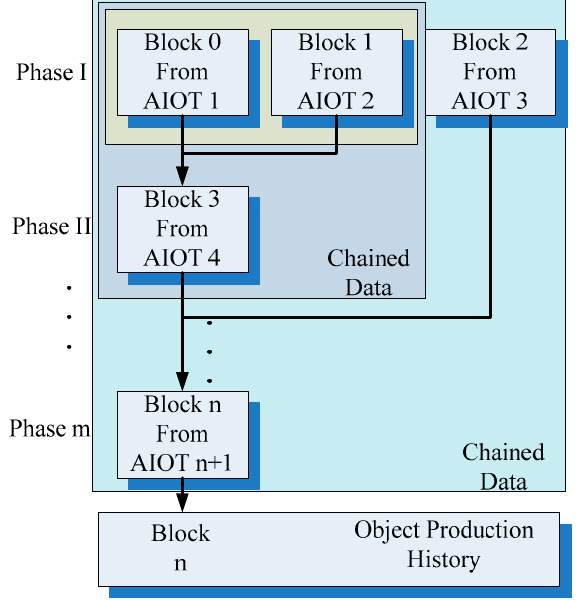
Figure 2. Proposed system for the transfer of blockchain information through IoT devices.